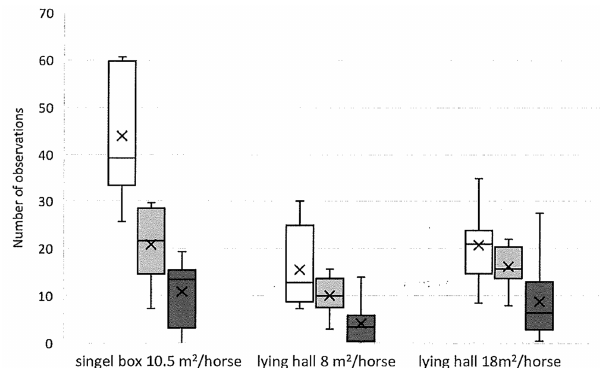
Figure 5. Median values for the resting observations of the horses in Study 2 ( n = 8), for different housing systems and different available lying areas. White boxes show standing rest, light grey boxes show sternal recumbency, and dark grey boxes show lateral recumbency. The horses exhibited longer standing rest in single boxes than in the lying halls. They spent longer in both sternal and lateral recumbency in single boxes and in the lying hall with a lying area of 18 m 2 /horse compared with the lying hall with a lying area of 8 m 2 /horse. In comparing activity in the lying halls, we can see that the horses spent more time foraging from the bedding when they had access to a lying area of 18 m 2 /horse than when they had access to an area of 8 m 2 /horse ( p < 0.0001) (Figure 6). There were no differences in standing attentive or other behaviors between the lying halls with different available lying areas. They did exhibit other behaviors in the lying halls, as compared with the single boxes, such as play. The horses also used the lying halls for urination. They were also standing attentive, which included foraging, in 8% of the observations. In the single boxes, the behavior of the horse was restricted during some observations by human interaction, when the horse was tied up while their box was cleaned, or handled by the groom in other ways. Figure 6. The chart shows the time budgets for single boxes and active open barn with lying areas of 8 m 2 and 18 m 2 in Study 2 in Strömsholm based on 10 horses.